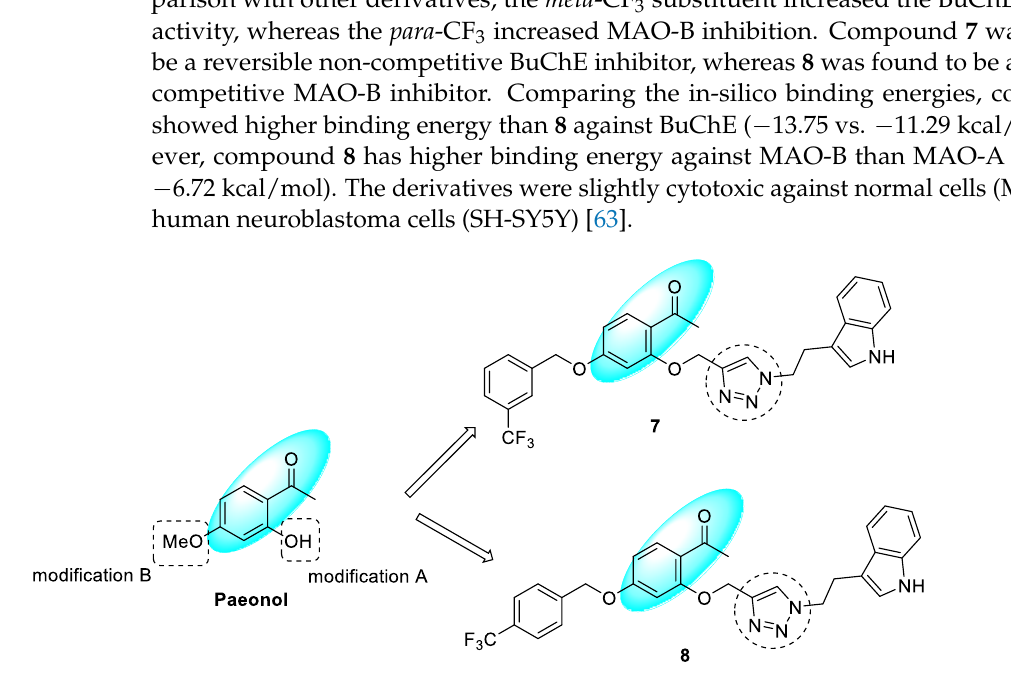
Figure 10. Chemical structures of paeonol – 1,2,3-triazole hybrids.